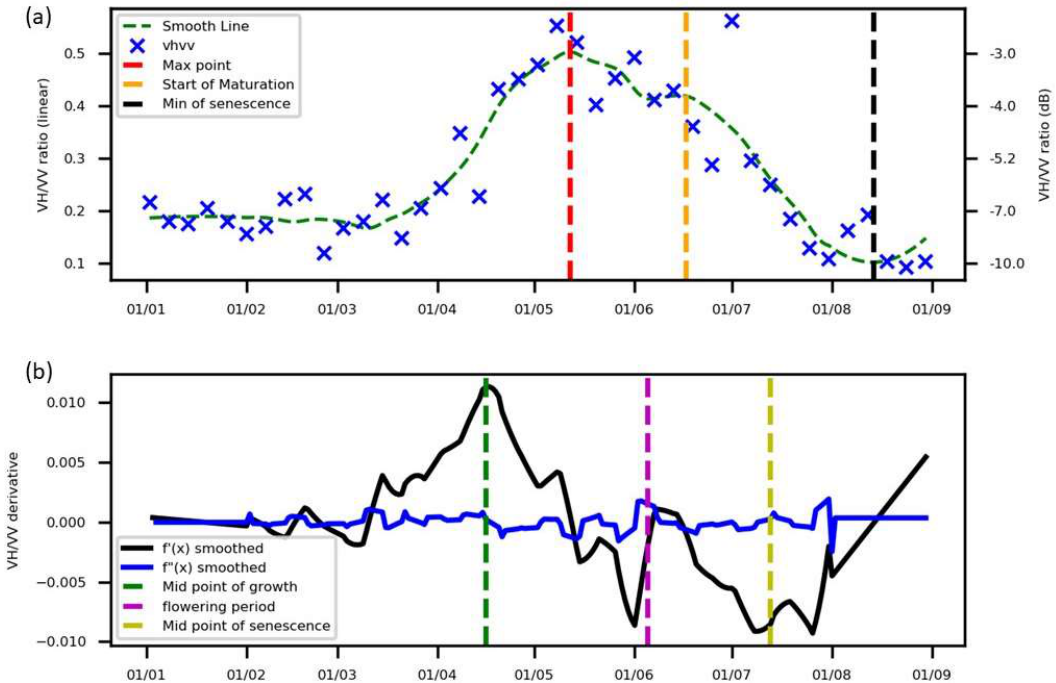
Figure 4. ( a ) Mean VH / VV ratio from Sentinel-1 orbit 132 of wheat field (for the Swayers_4 field in 2018) together with a smoothed curve of the mean (with the date of the maximum point indicated) and ( b ) first (f’x) and second (f’’x) derivative (bottom) of the smoothed field-averaged line. The date of the midpoint of the growth period, and the date of the start, midpoint, and minimum value of the maturation period are indicated as vertical dotted lines. The secondary y axis in the first graph displays the VH / VV ratio on a decibel scale for